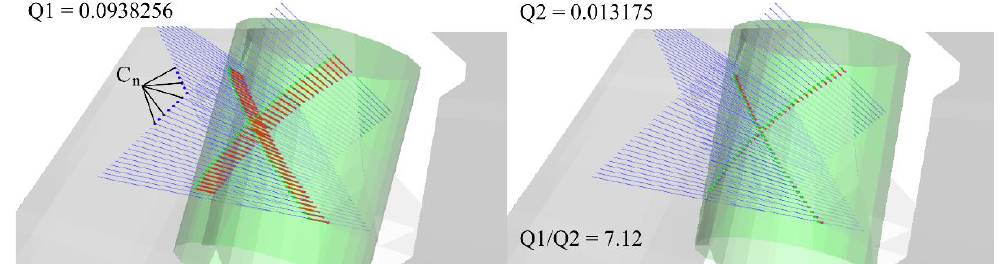
Figure 9. Results of point clouds alignment.